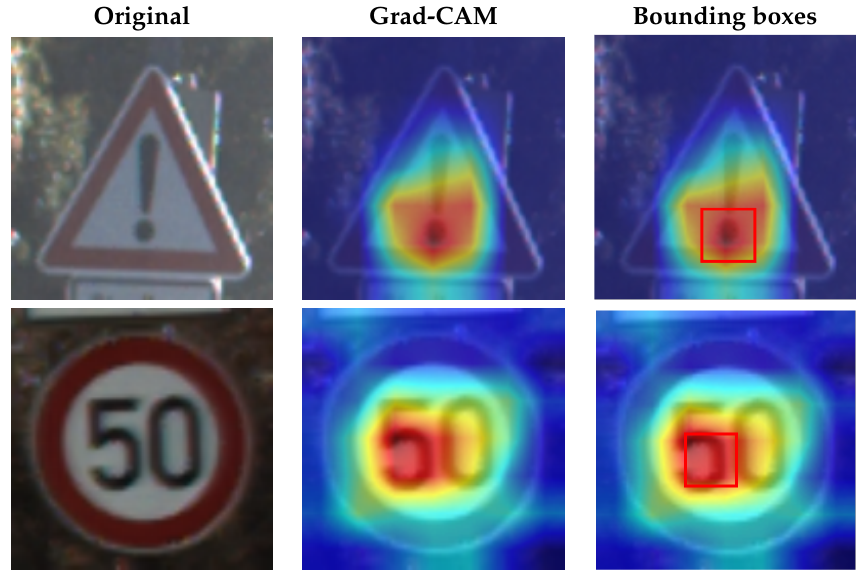
Figure 2. Samples of Grad-CAM visualizations and bounding boxes on traffic